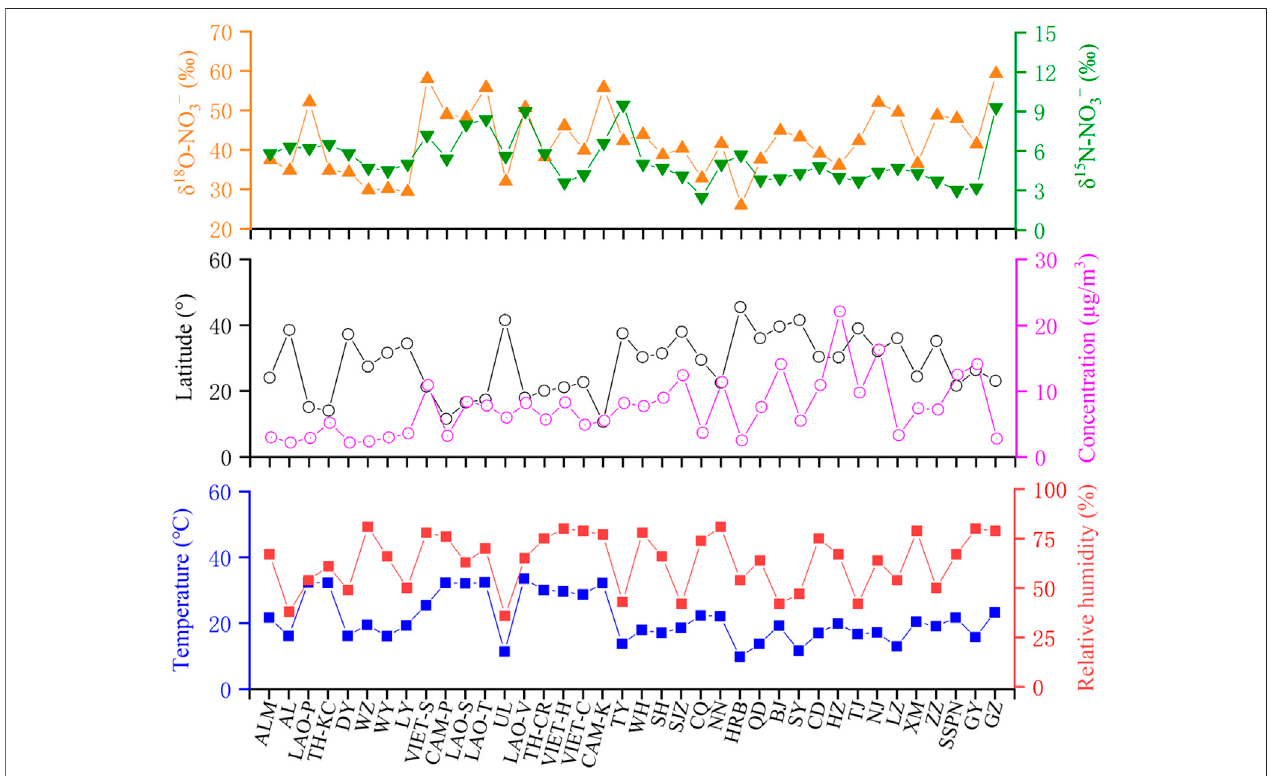
FIGURE 3 | Characteristics of (A) δ 15 N-NO 3 − and δ 18 O-NO 3 − values, (B) NO 3 − concentrations and latitude, and (C) relative humidity and ambient temperature in the CICP during the sampling period.